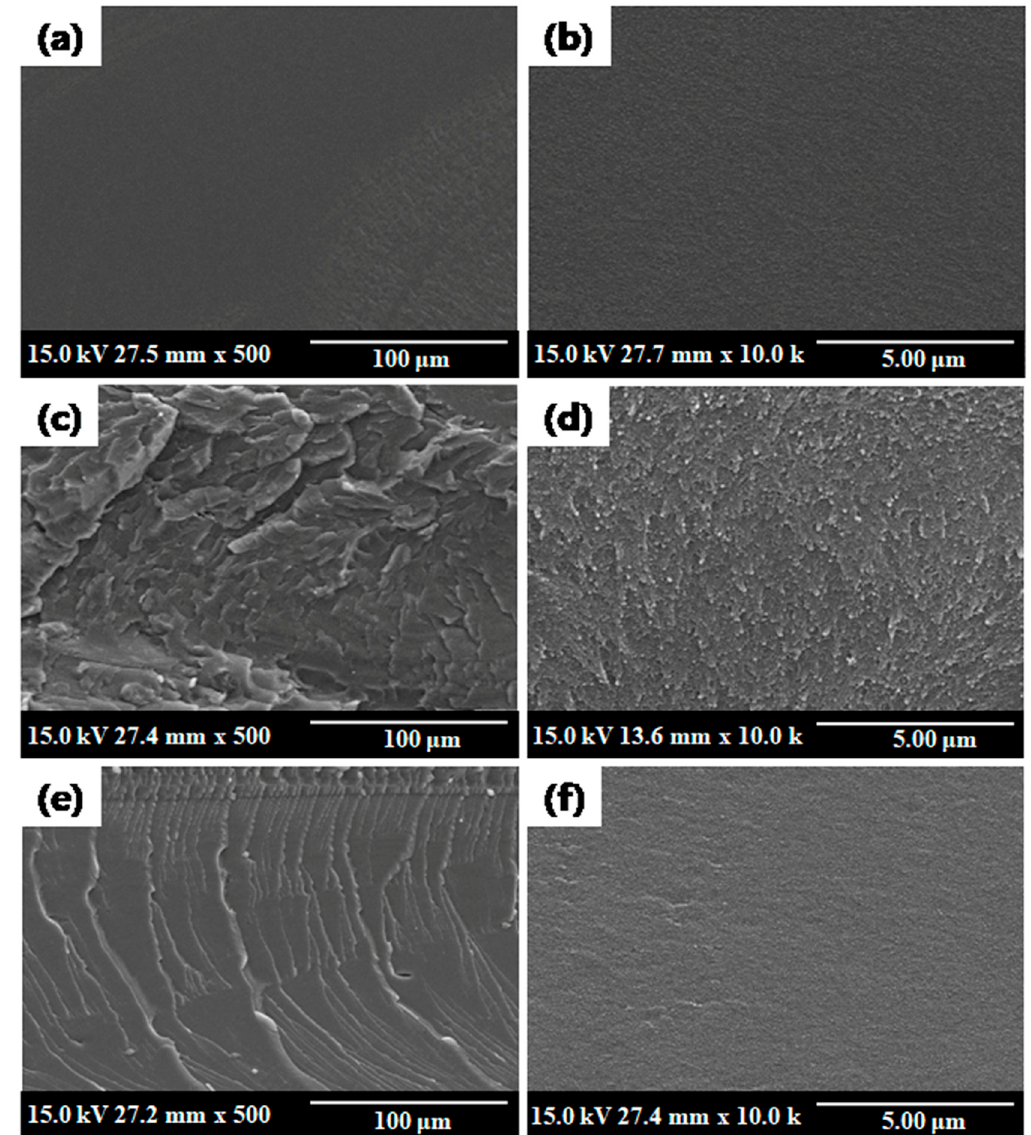
Figure 2. Cross-sectional SEM images of quaternized PPO (qPPO) ( a , b ), qPPO/D-Cel7 ( c , d ), and qPPO/DG-Cel7 ( e , f ) membranes.